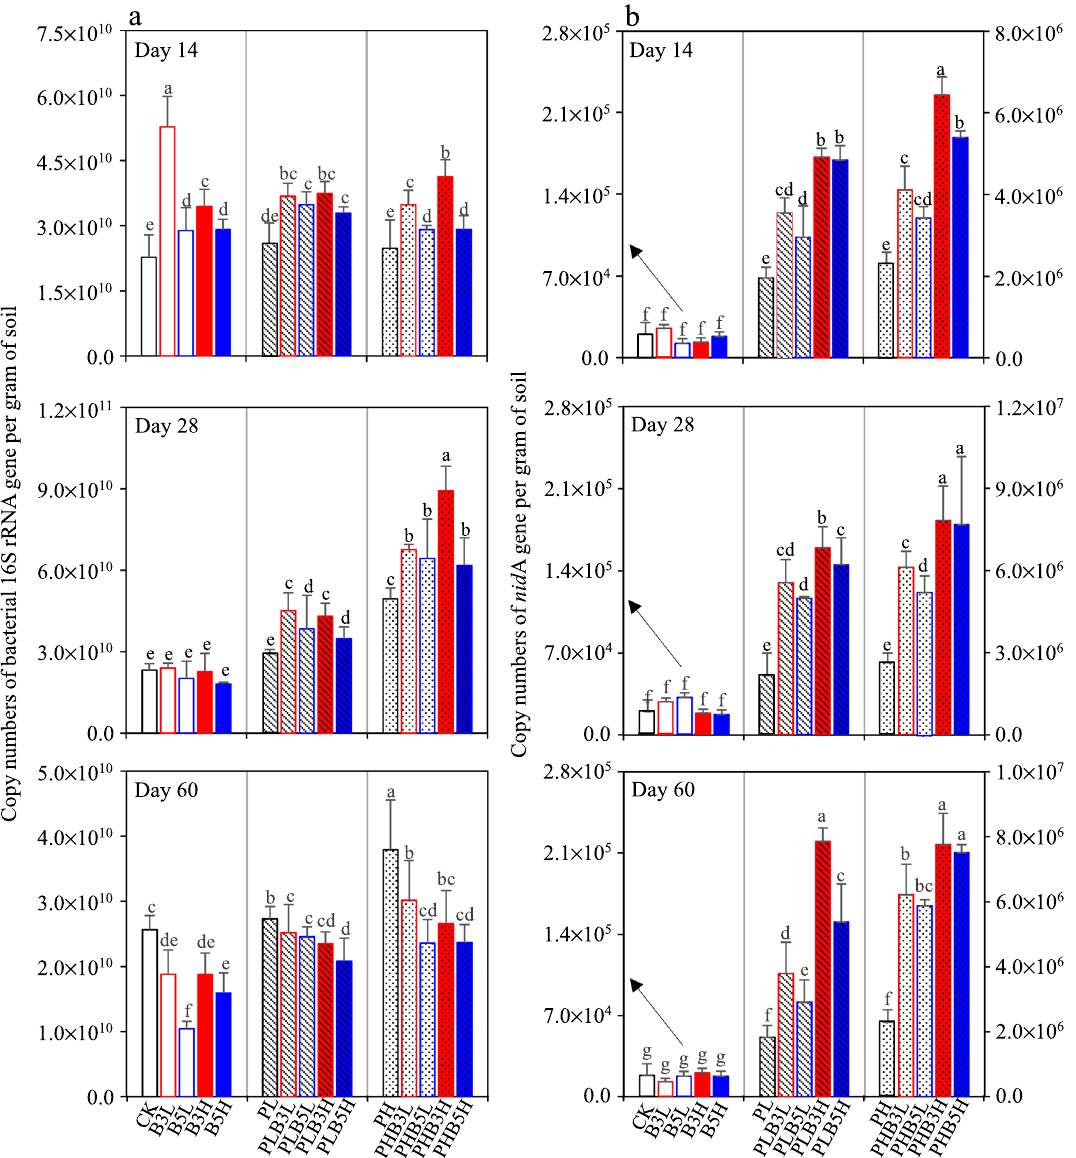
Fig. 2 Copy numbers of 16S rRNA ( a ) and nid A ( b ) genes in soil under single and combined exposures of phenanthrene and biochar on various incubation days. CK indicates soil without any amendment. PL and PH indicate that containing only phenanthrene at 2 and 20 mg kg − 1 , respectively. BnL and BnH indicate clean soil amended with low (0.03%) and high (0.3%) doses of biochar, respectively. PLBnL and PLBnH indicate low-concentration phenanthrene-spiked soil amended with low and high doses of biochar, respectively. PHBnL and PHBnH indicate high-concentration phenanthrene-spiked soil amended with low and high doses of biochar, respectively. “n” indicates charring temperatures of 300 and 500 °C. Different letters indicate significant differences at p <